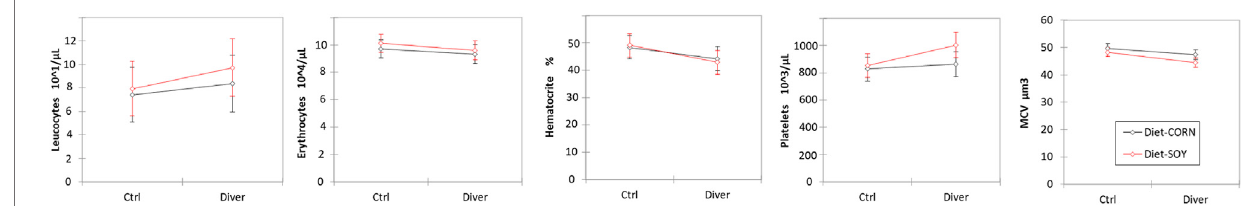
FIGURE 2 | Blood cells count in Control and Diver rats, according to their diet (MAIZE or SOY).